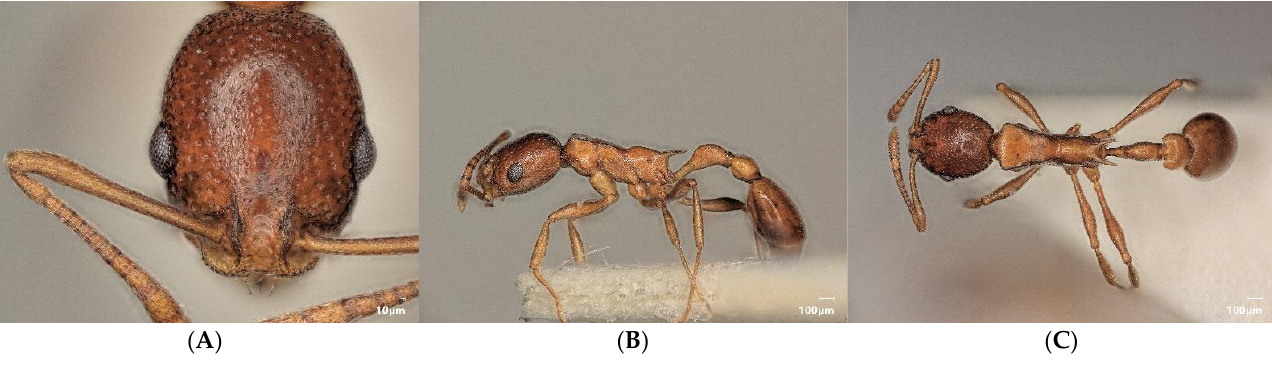
Figure 22. Cardiocondyla thoracica : head in dorsal view ( A ), lateral view ( B ), dorsal view ( C ), vertex median of the eye ( D ).